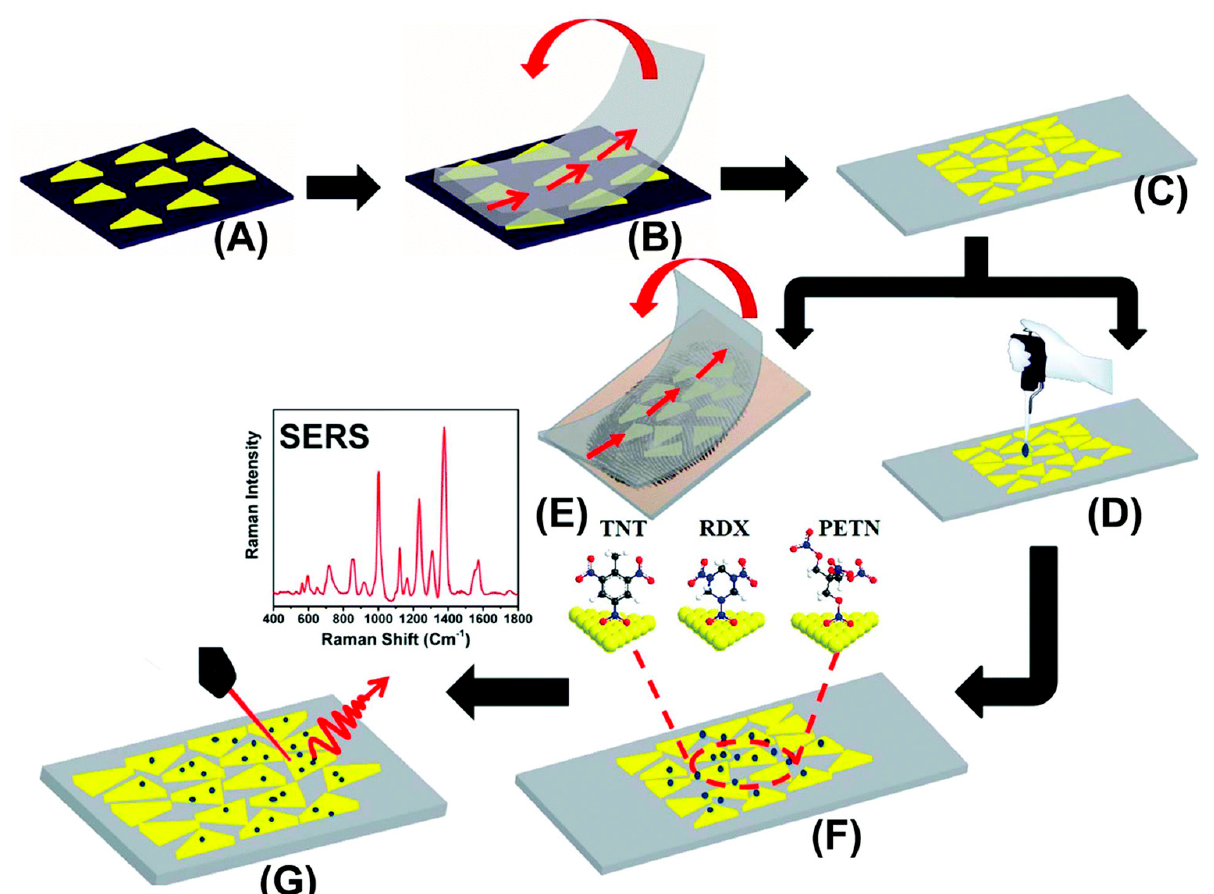
Figure 4. Design of Au-NPR (gold nanoprism)-based SERS nanosensor for detection of trace explosives: ( A ) a self-assembled layer of Au-NPRs on an APTES (3-aminopropyl)-triethoxysilane) functionalized glass coverslip was prepared. ( B ) Au-NPRs were transferred to a flexible adhesive substrate by the stamping technique, which produced a SERS nanosensor ( C ). Explosive molecules were either drop-casted from a solution ( D ) or transferred from a thumb impression ( E ) directly onto the SERS nanosensor ( F ). ( G ) SERS spectra were collected using benchtop Raman spectrometer at a 785 nm diode laser excitation. The fabrication approach of SERS nanosensor is a schematic representa- tion; none of the figures present an exact number and/or density of Au-NPRs in each step. The image is not to scale. Reproduced with permission from [98], Analyst; published by The Royal Society of Chemistry, 2018.